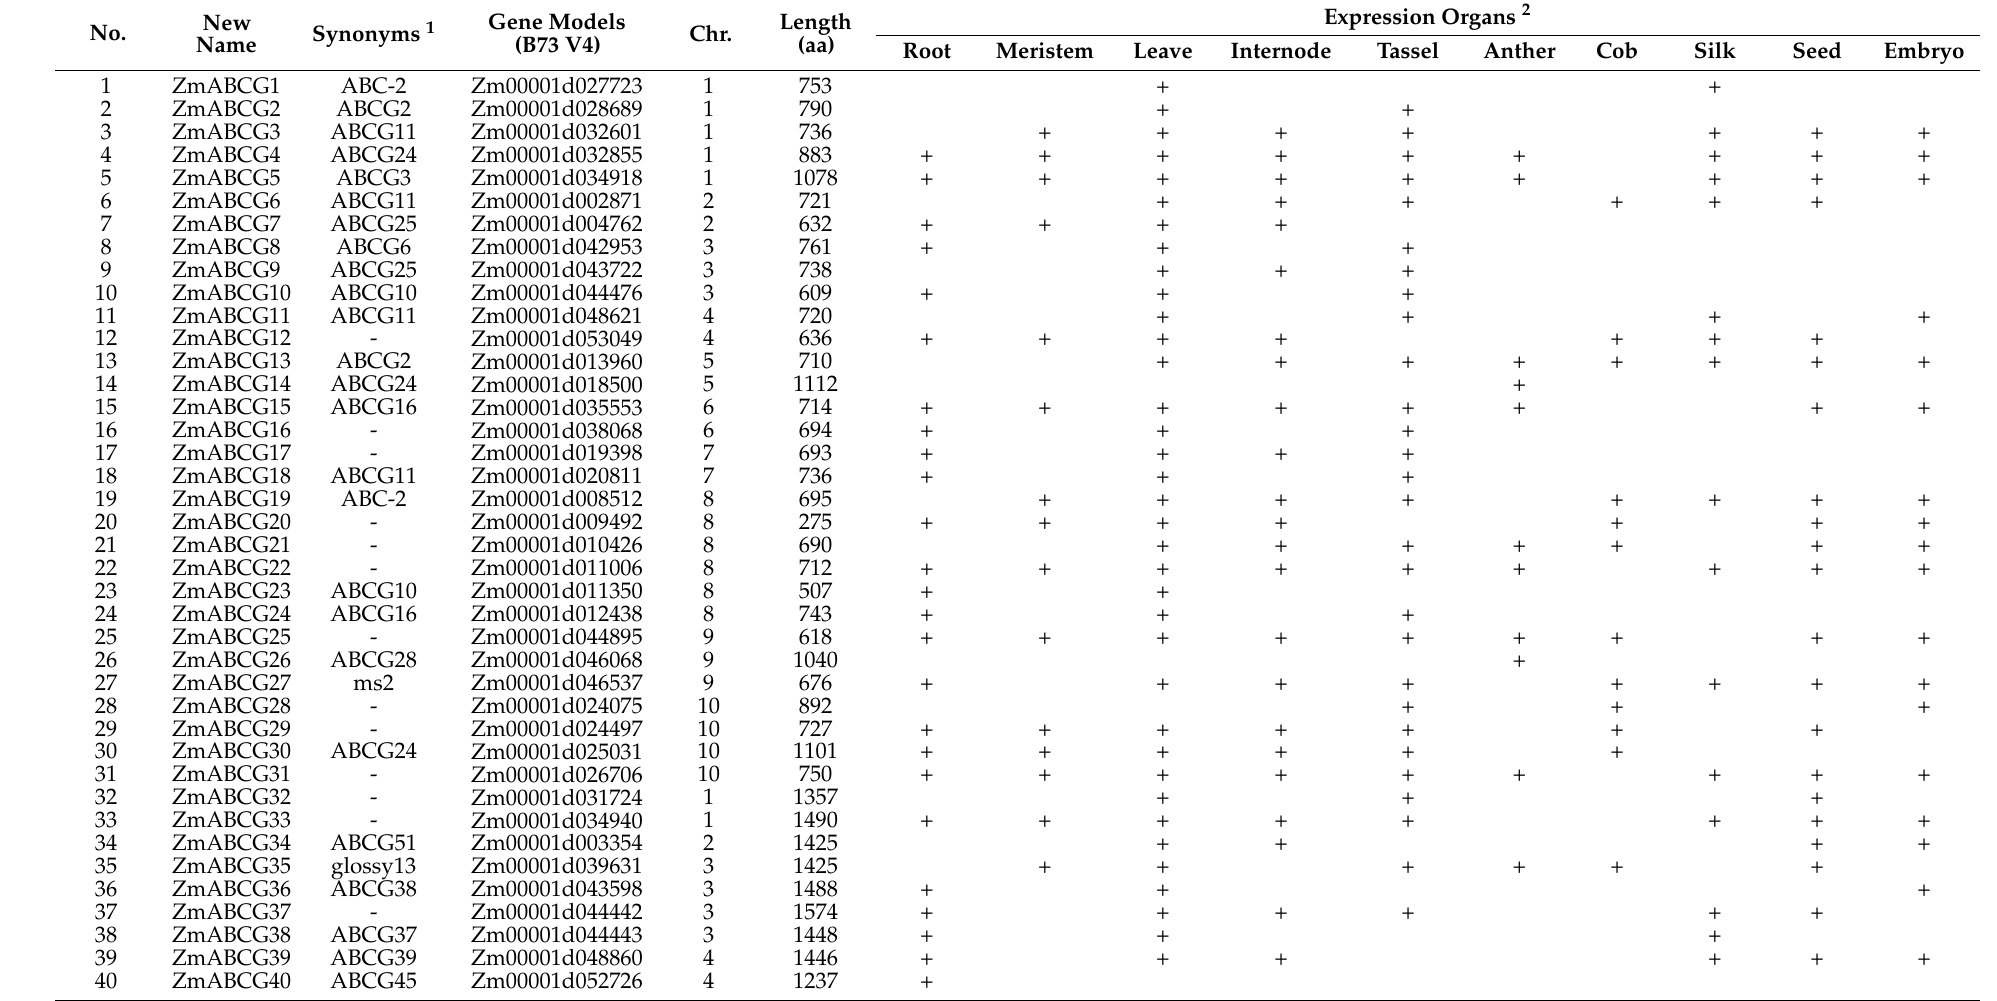
Table 1. The maize ABCG Subfamily: new nomenclature based on B73 reference genome V4.0 and pre-existing